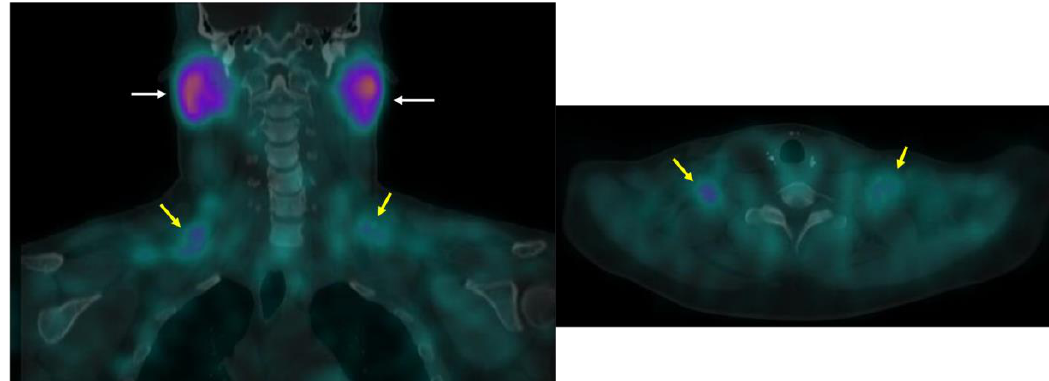
Figure 9. 99m Tc-MIBI uptake in iBAT on a clinical scan. Supraclavicular BAT uptake shown coronal and axial fused 99m Tc-MIBI-SPECT/CT (yellow arrows). Salivary gland uptake (white arrows) is normal.